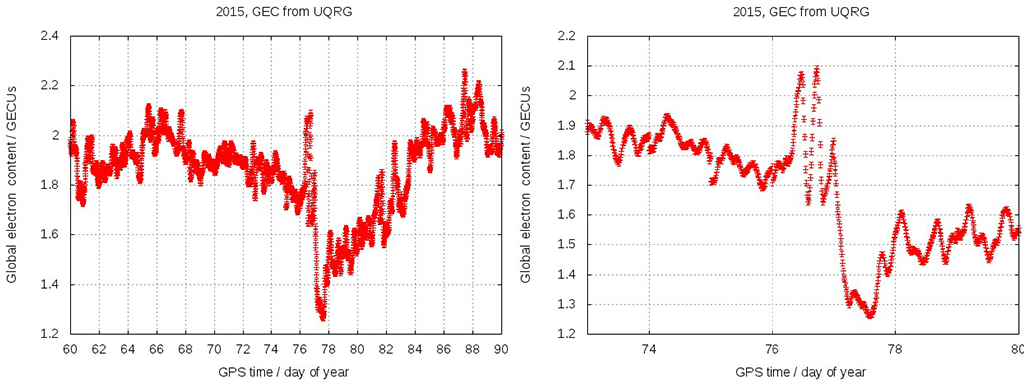
Figure 15. GEC trend derived from UQRG 15min GIMs for the days surrounding the St. Patrick’s Day storm (days 60 to 90 on the left and zoom on days 73 to 80 on the right).